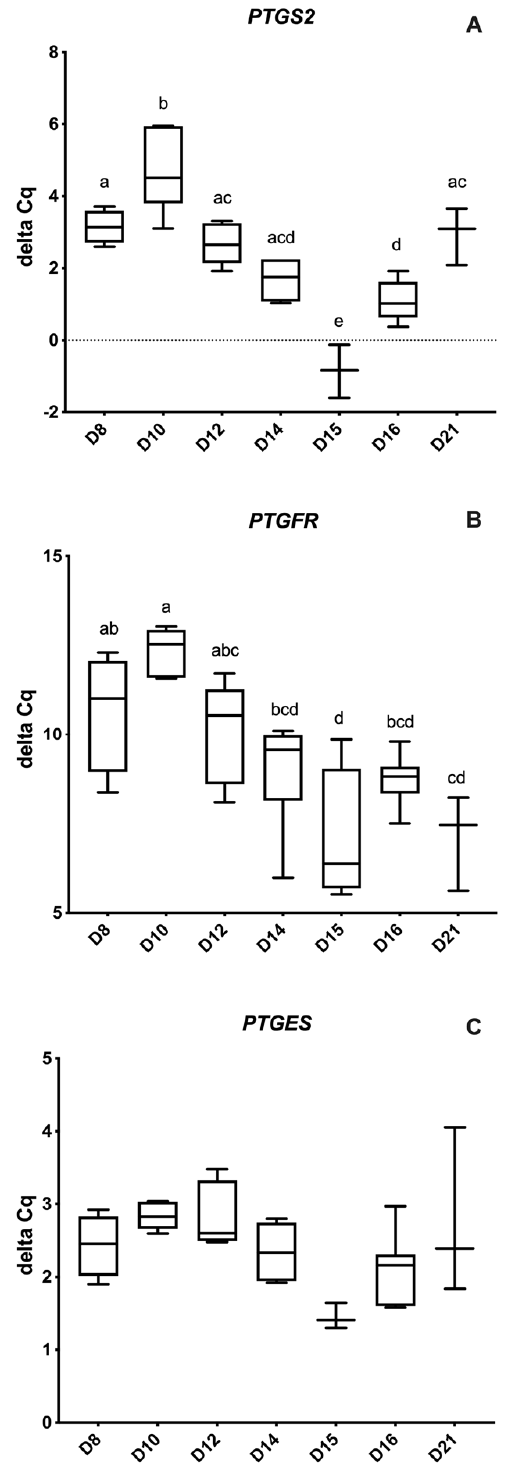
Figure 4. Relative abundance (delta Ct) of prostaglandin-related genes by embryonic age (Days 8 to 21 post-ovulation); ( A ) Prostaglandin-Endoperoxide Synthase 2 ( PTGS2 ), ( B ) Prostaglandin F Receptor ( PTGFR ) and ( C ) Prostaglandin E Synthase ( PTGES ). Differences between days ( p < 0.05) are indicated by different superscripted letters.